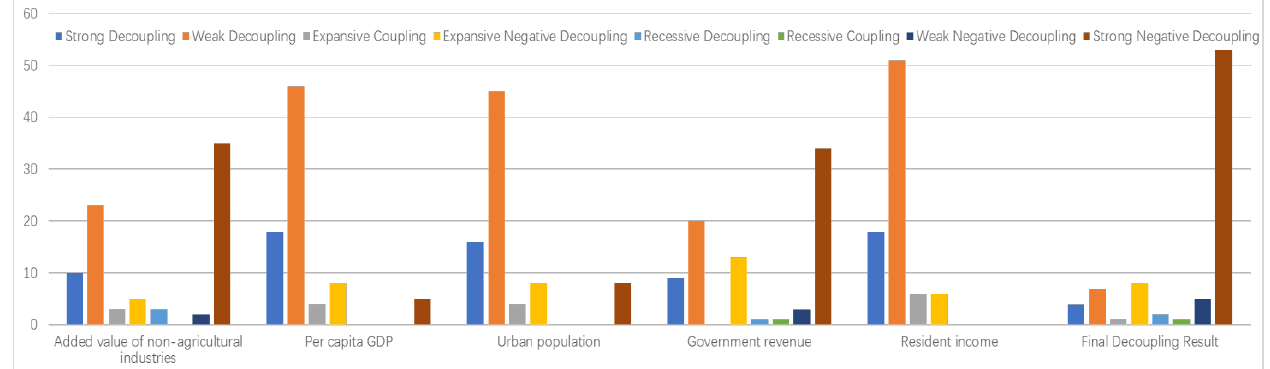
Figure 9. Statistical analysis of decoupling results in Gansu.